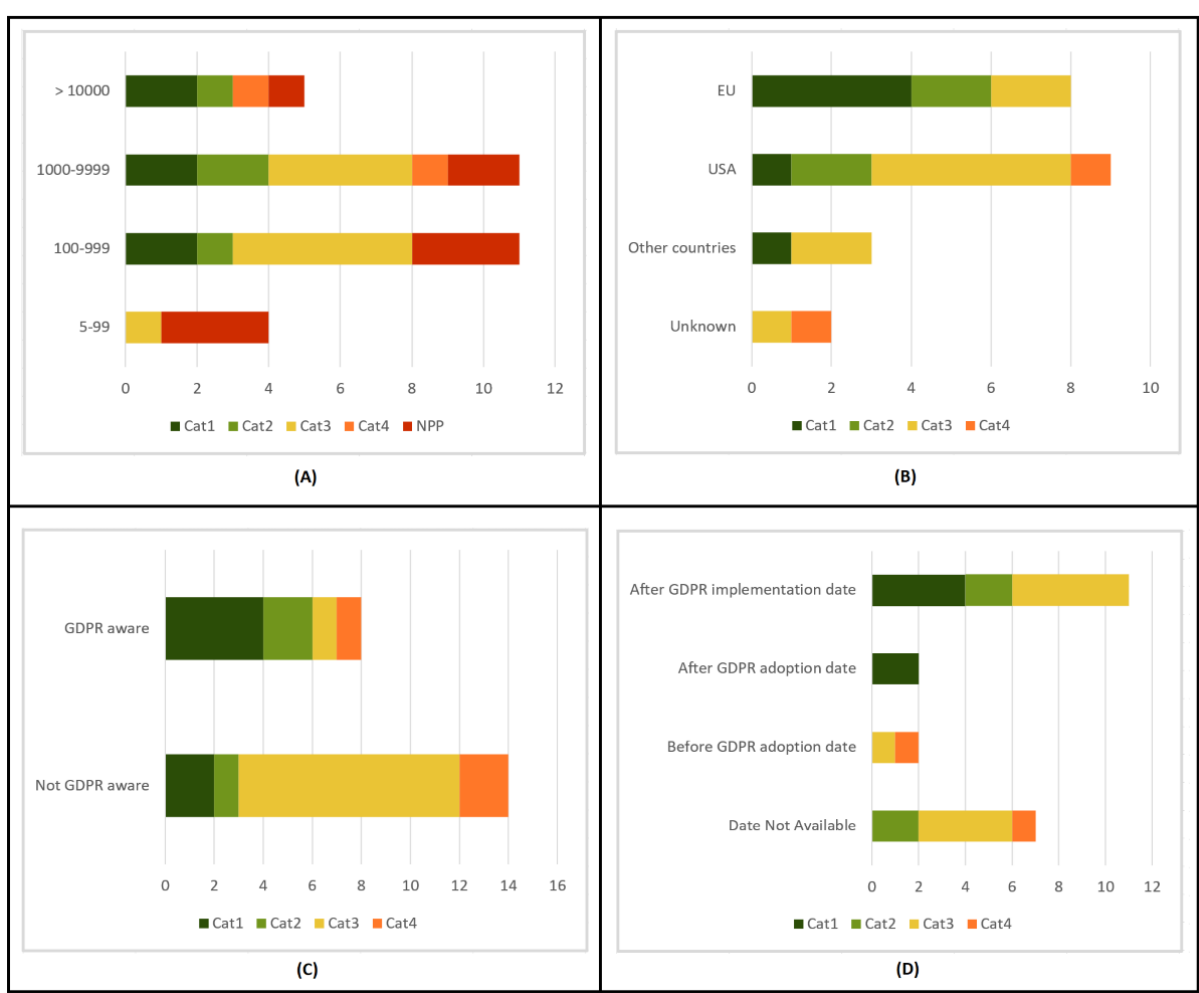
Figure 4. Privacy score summary